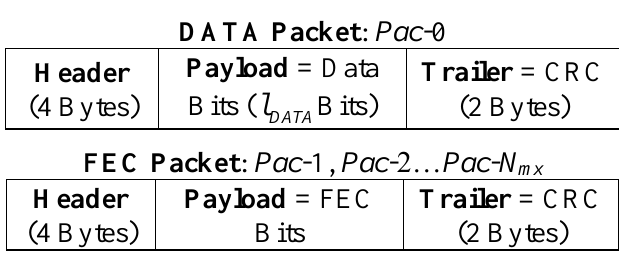
Figure 3. Final Link Layer Packet